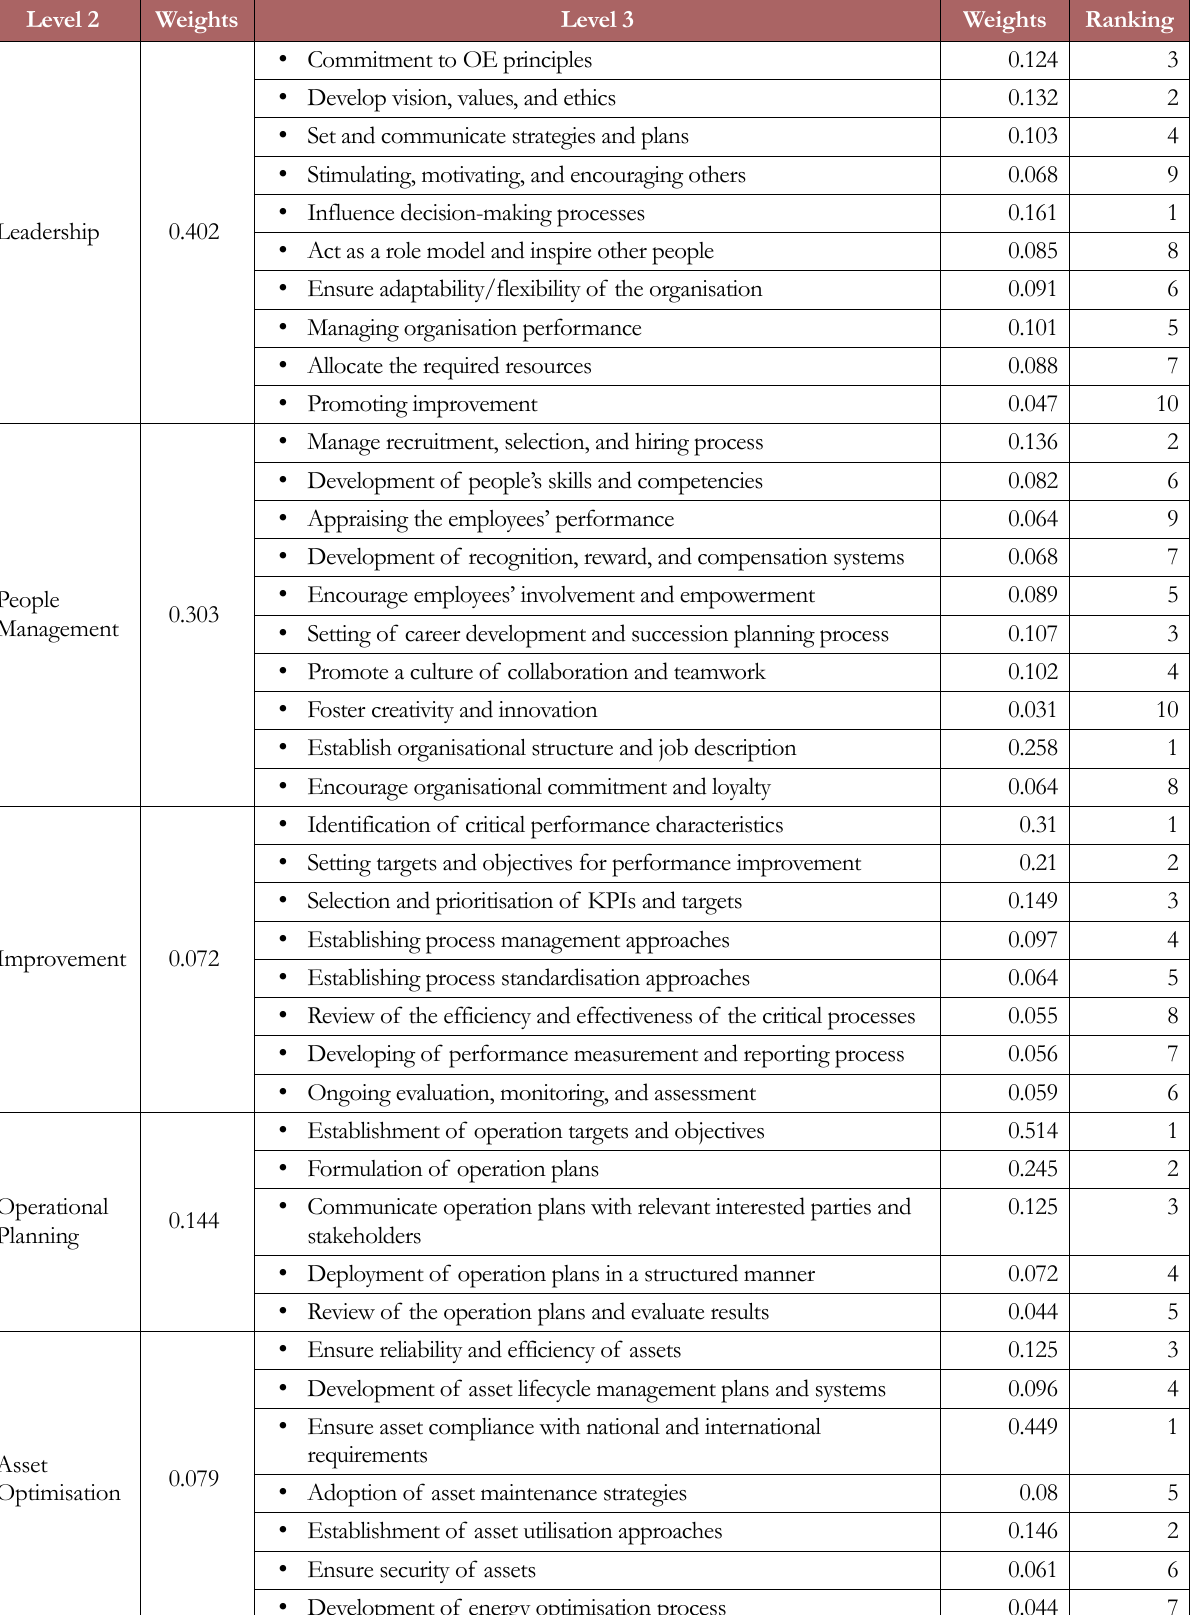
Table 5. Normalised Local Weights of Judgment and Ranking for Enabling Factors and Subfactors Based on the Outcomes of Expert